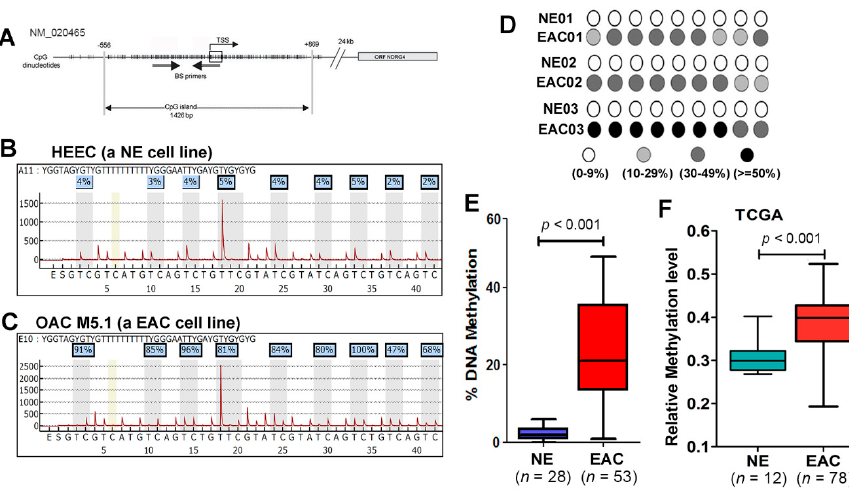
esophagus; EAC, esophageal adenocarcinoma.